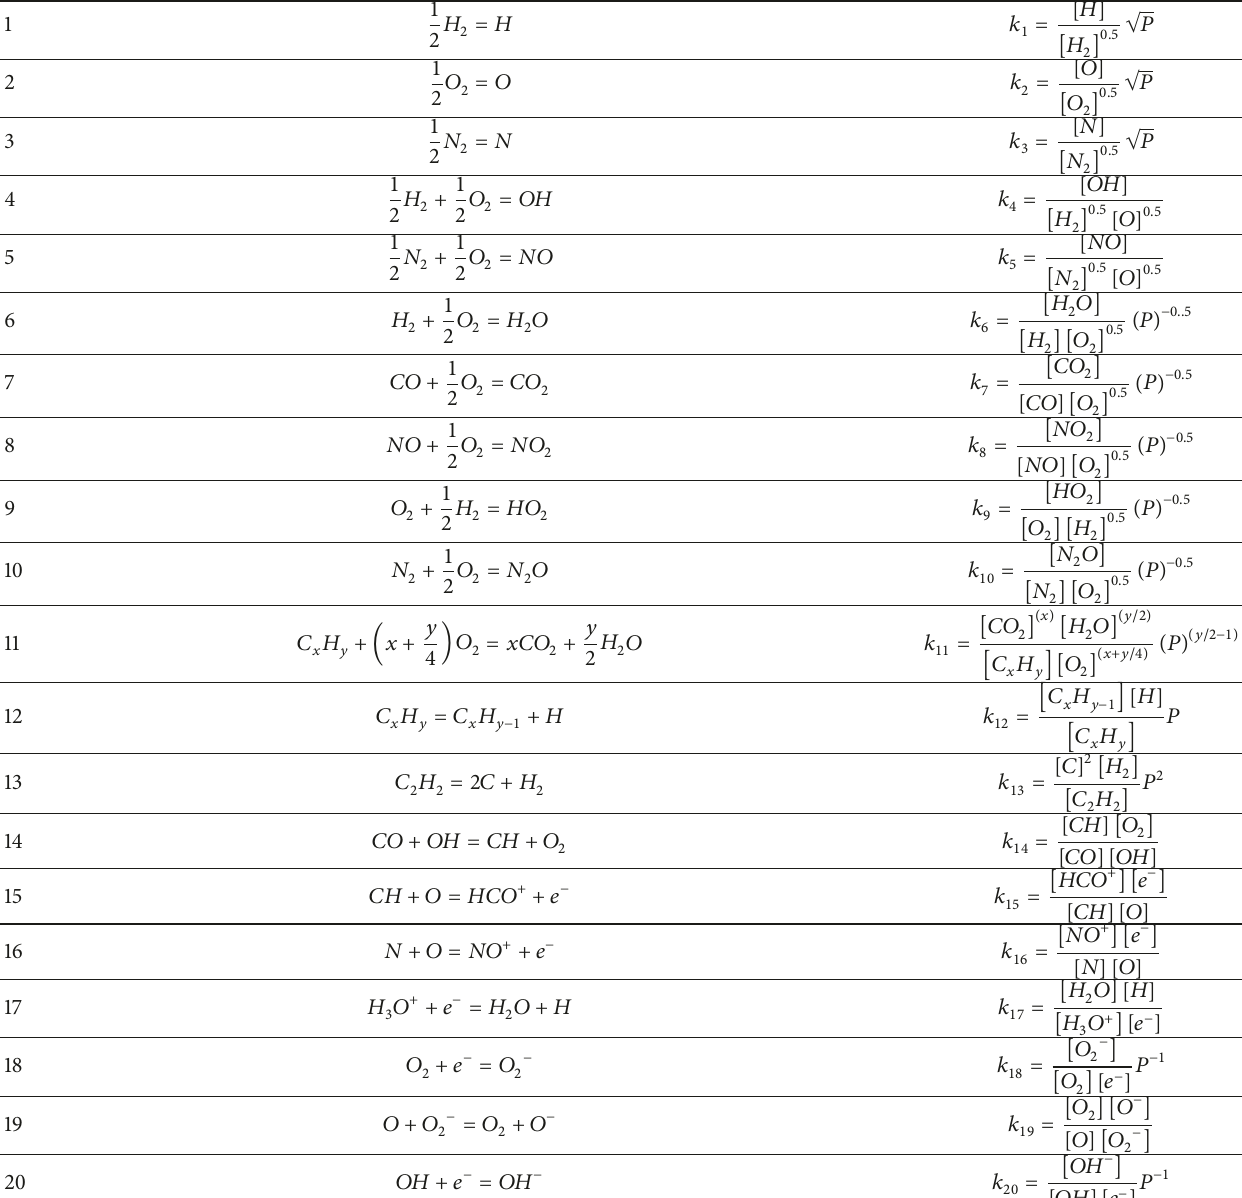
Table 7: List of